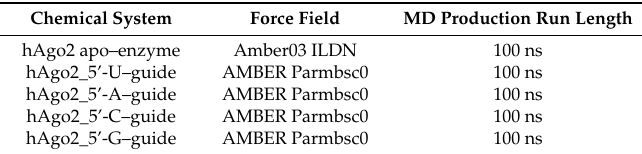
Table 1. List of simulations performed. For details, see Materials and Methods.